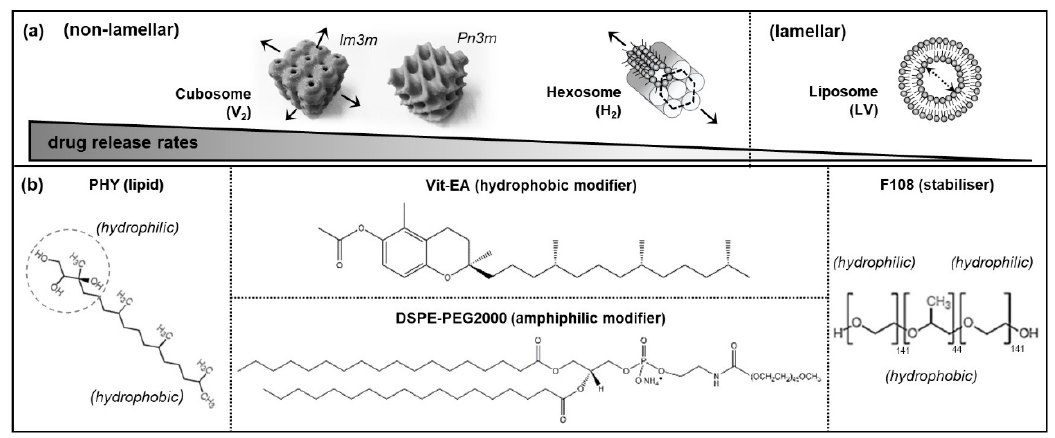
Figure 1. ( a ) Schematics depicting the non-lamellar and lamellar structures and their corresponding drug release rates, where the arrows indicate the possible paths of cargo release; ( b ) molecular structure of the formulation components: the parent lipid, phytantriol (PHY); hydrophobic modifier, Vitamin E acetate (Vit-EA); amphiphilic modifier, 1,2-distearoyl- sn -glycero-3-phosphoethanolamine-N-[amino(polyethylene glycol)-2000 (DSPE-PEG2000); and stabiliser, Poloxamer 388 (F108).